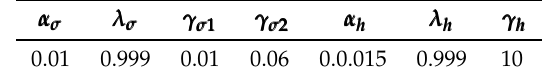
Table 4. Parameter values for the Return and Speed